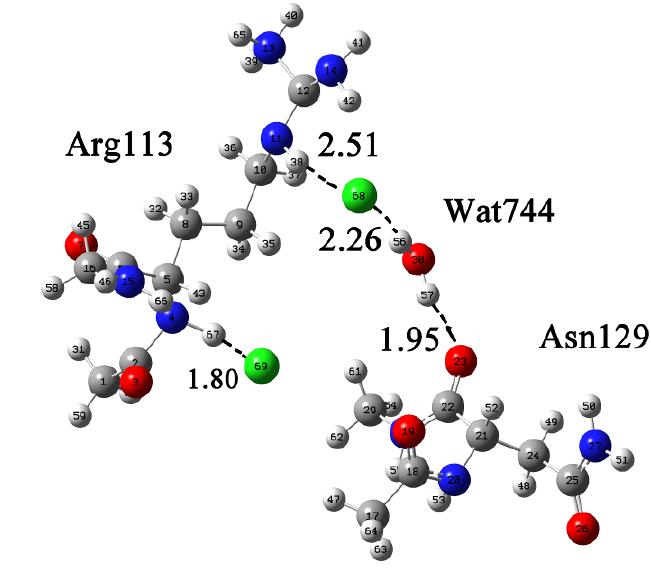
O · Asn supermolecular system displayed in Gaussian Figure 2. The calculated Arg · 2HCl · H 2 View. The coordinates of Arg113, Asn129, and Wat744 were taken from Protein Data Bank [23], and two Cl − and hydrogen atoms were manually added by Gaussian